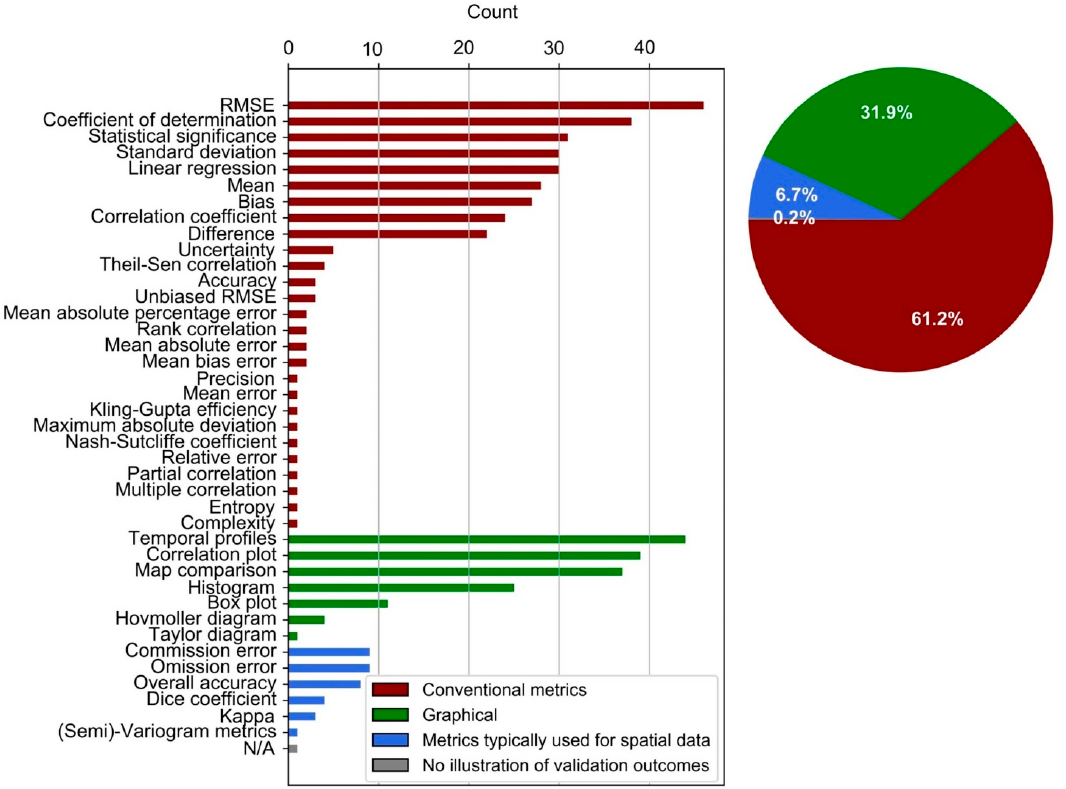
Figure 14. Frequency of the concepts / metrics used for the expression of validation results in the reviewed studies.